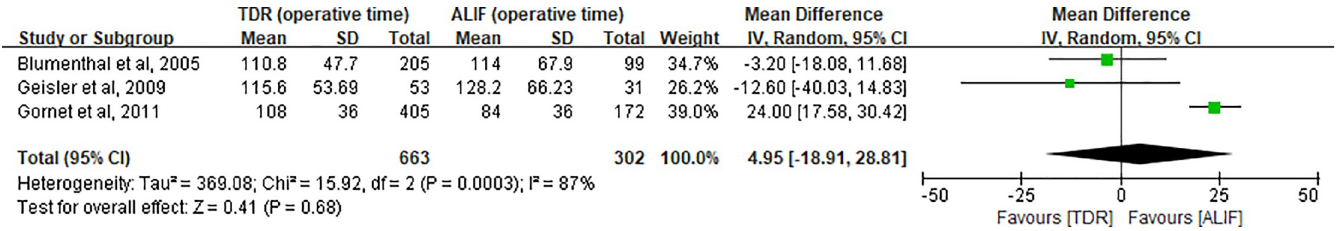
Fig 2. Forest plot for operative time. df = degrees of freedom, and IV = Inverse